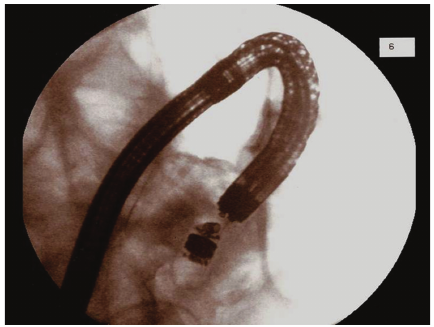
Figure 3: Capsule retrieval under fluoroscopy.